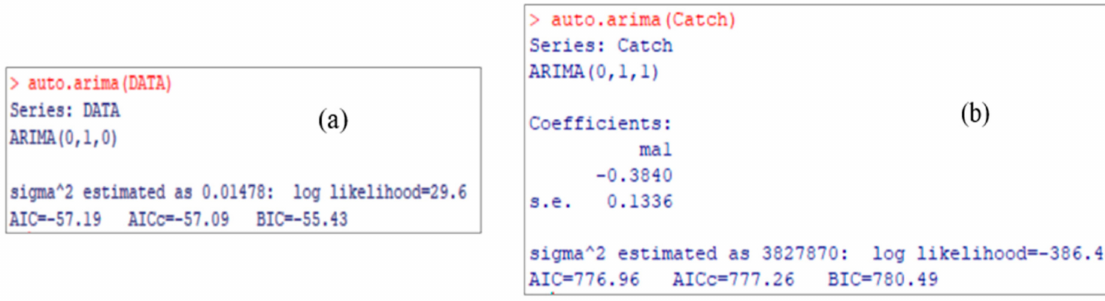
Figure 6. Estimated values for ARIMA (0,1,1) ( a ) and ARIMA (0,1,0) ( b